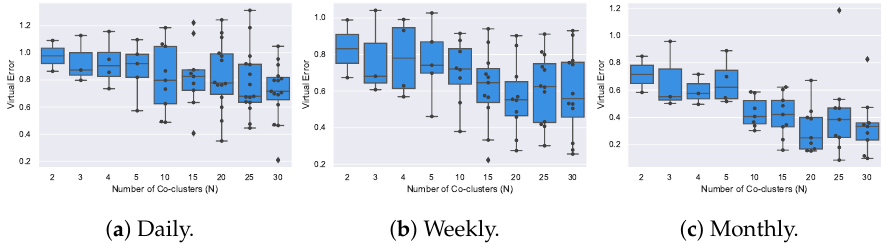
Figure 16. Homogeneity and number of coclusters ( N ) for the spectral Coclustering of scaled daily, weekly, and monthly consumption at InfraQuinta,